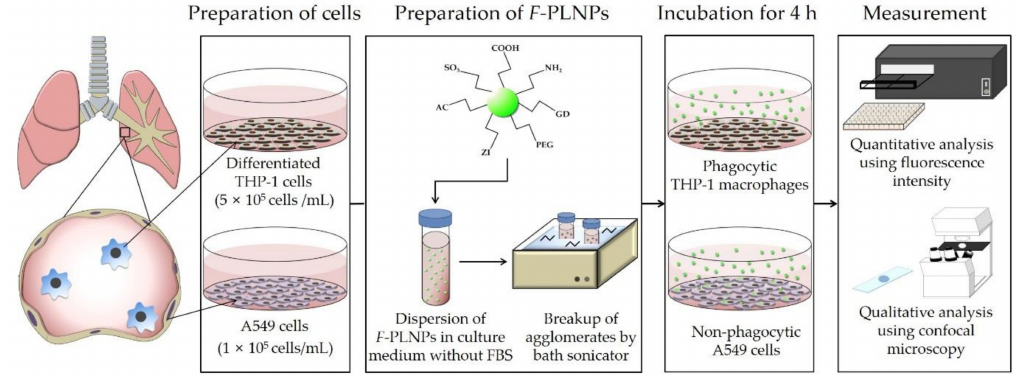
Figure 1. Study design of fluorophore-conjugated polystyrene nanoparticle ( F -PLNP) uptake in THP-1 cells and A549